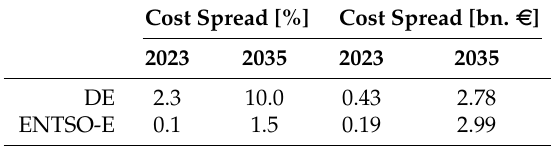
Table 3. Economic benefit of CB-ID trading (spread between “w/o XBID” and